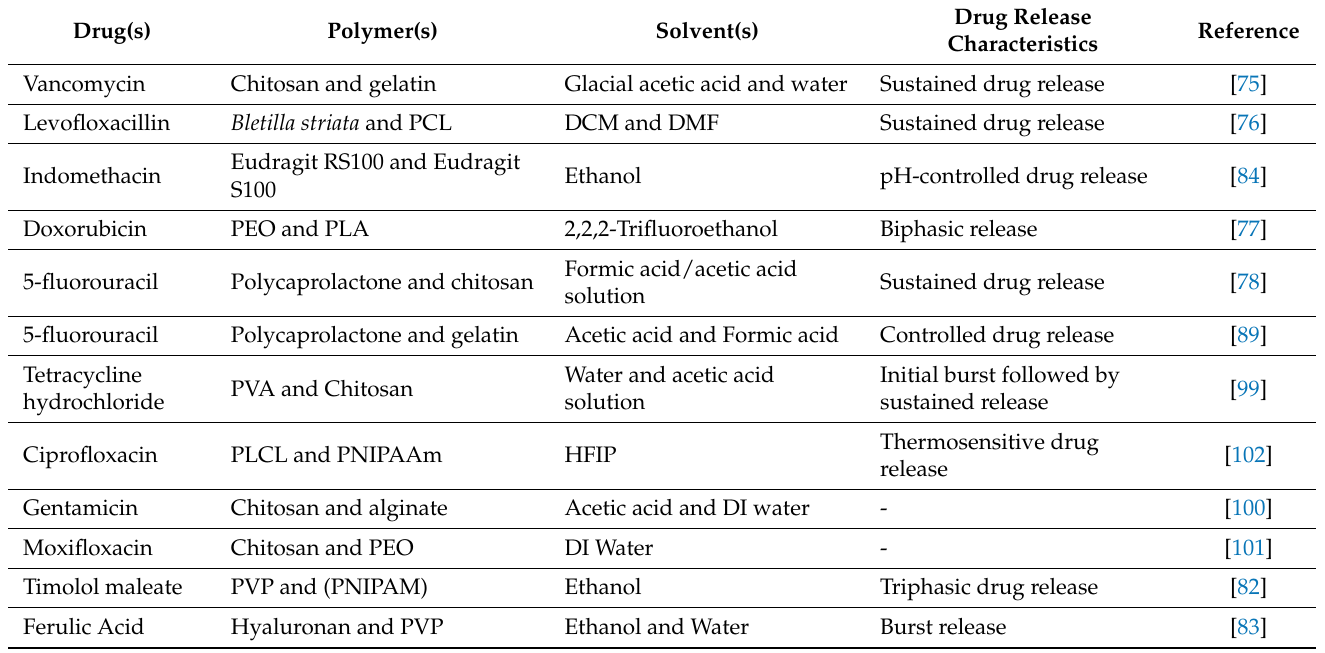
Table 2. Summarised characteristics of some studies employing monoaxial electrospinning for drug delivery applications.